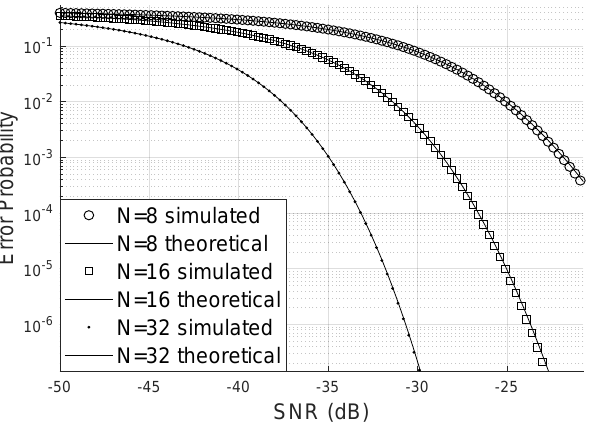
Figure 5. Error probability without phase errors.